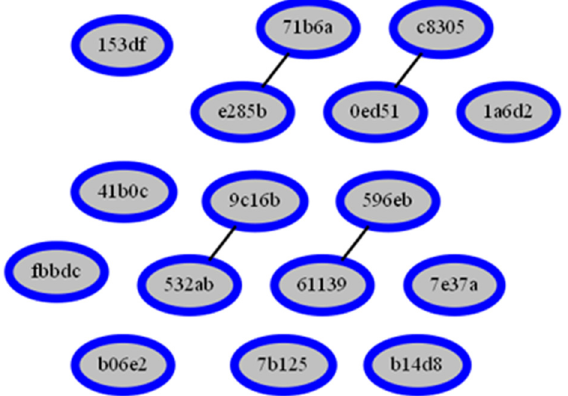
Figure 21. Import table similarity graph.